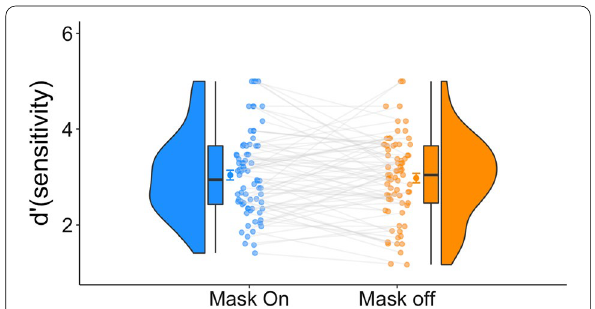
Fig. 4 Experiment 3 results. Similar accuracy results were observed for the two masking conditions. For each condition we present the distribution, the individual datapoints, and the quartiles of the dataset. The whiskers depict the rest of the distribution excluding outliers. The darker dots denote the means, and the error bars denote one standard